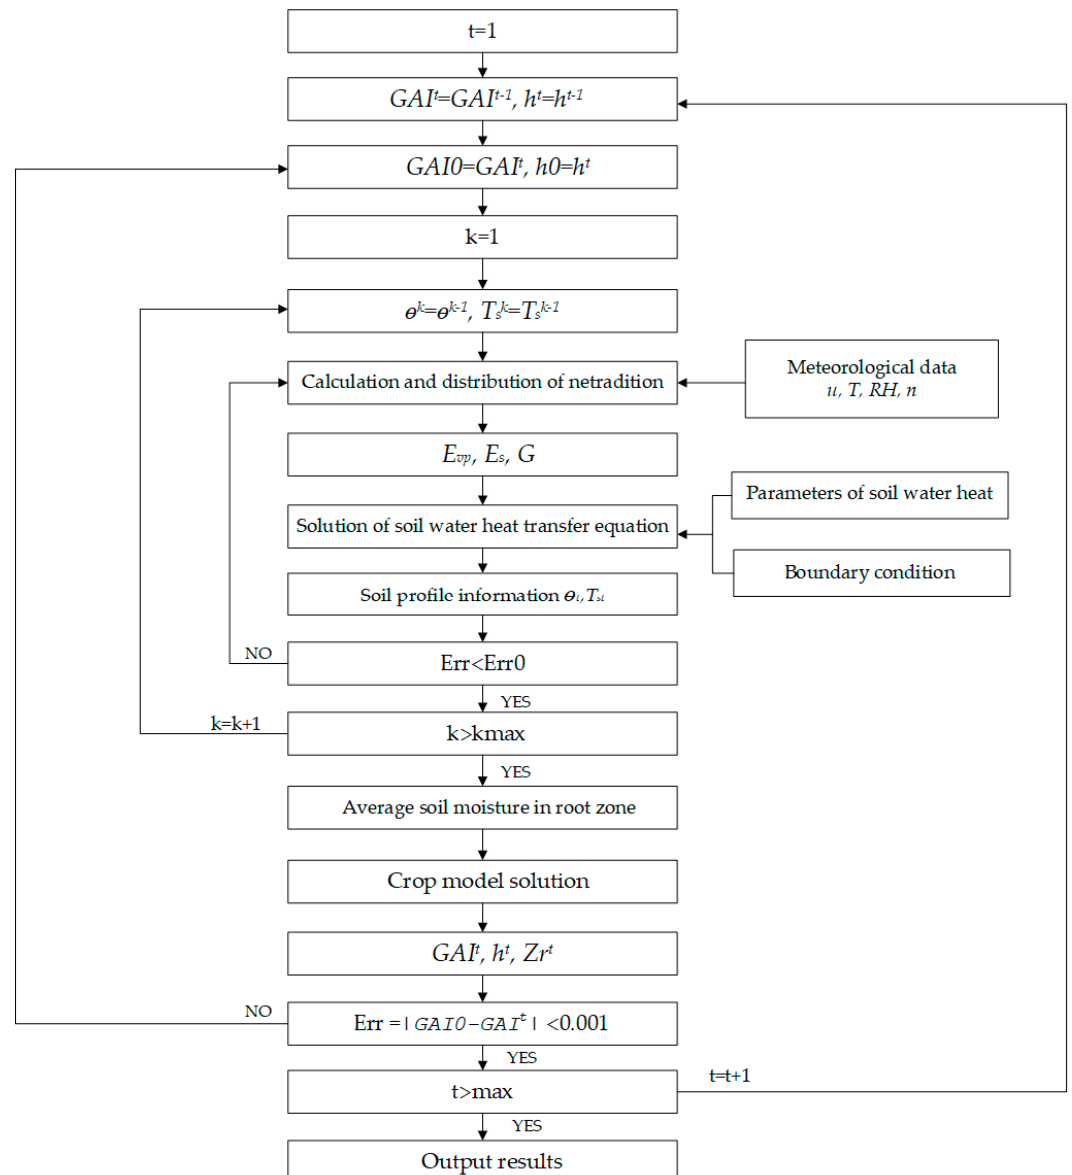
Figure 2. Calculation flowchart of the CropSPAC model. The GAI is the green area index; E vp is the potential transpiration; E s is the soil evaporation rate; G is the downward heat flux in the soil surface; u is the wind speed; T is the air temperature; RH is the relative humidity; and n are the sunshine hours.